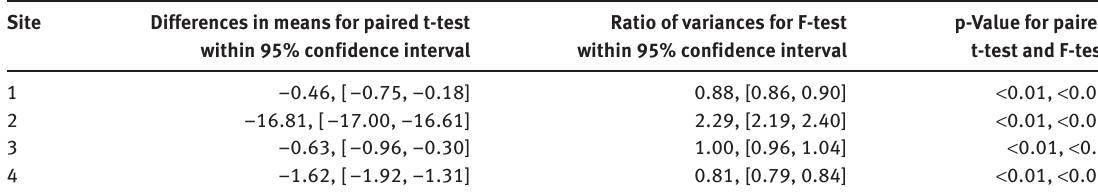
Table 6: Comparisons of Differences between Means and Variances Using Paired t-Test and F-test, p-Value with 95% Confidence Level at Different Sites for the Cars (C2) and Trucks